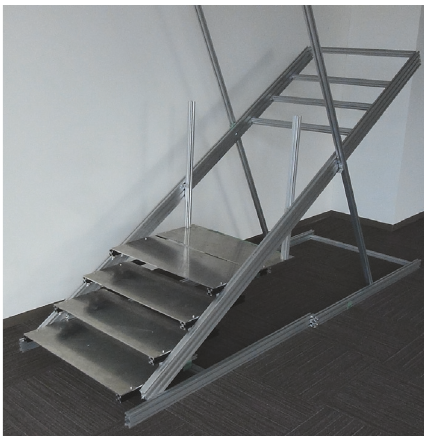
Figure 16: Tracked robot used in tests.